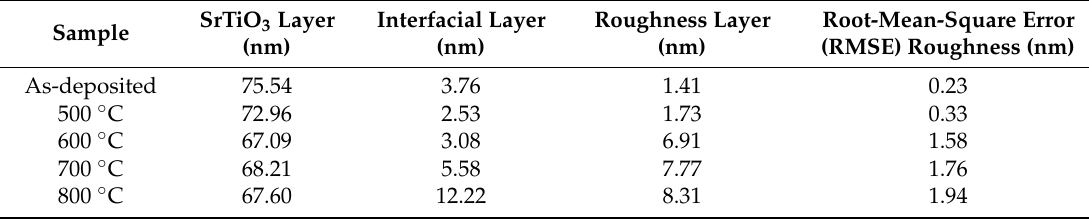
Table 1. Thickness data of the SrTiO 3 films annealed at different temperatures. SrTiO 3 Layer Interfacial Layer Roughness Layer Root-Mean-Square Error Sample (nm) (nm) (nm) (RMSE) Roughness (nm) As-deposited